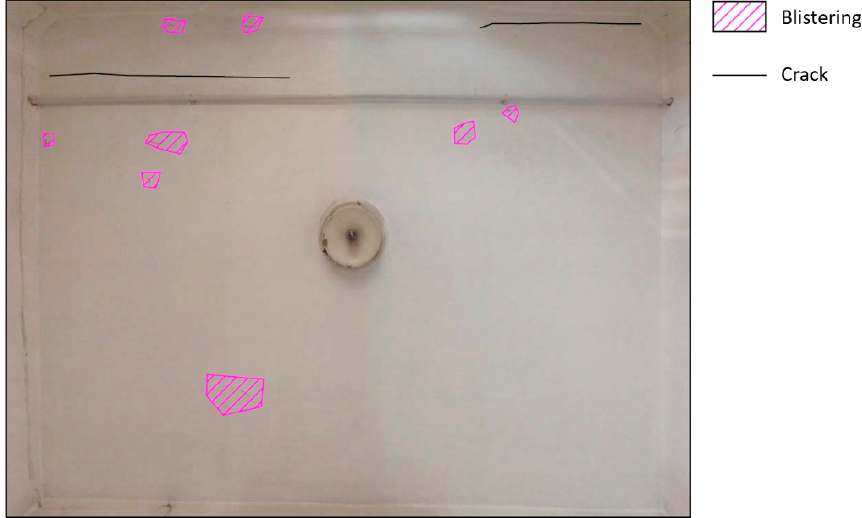
Figure 7. Results for the ceiling of the room. Areas were directly mapped on the rectified image to calculate areas and costs.